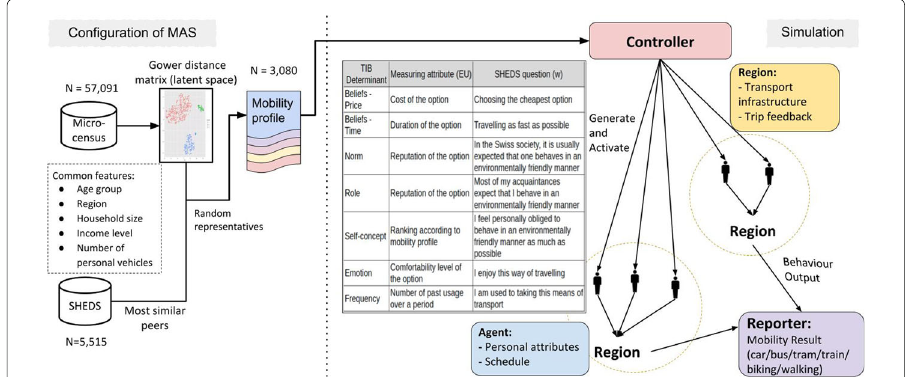
Fig. 4 BedDeM data mapping and